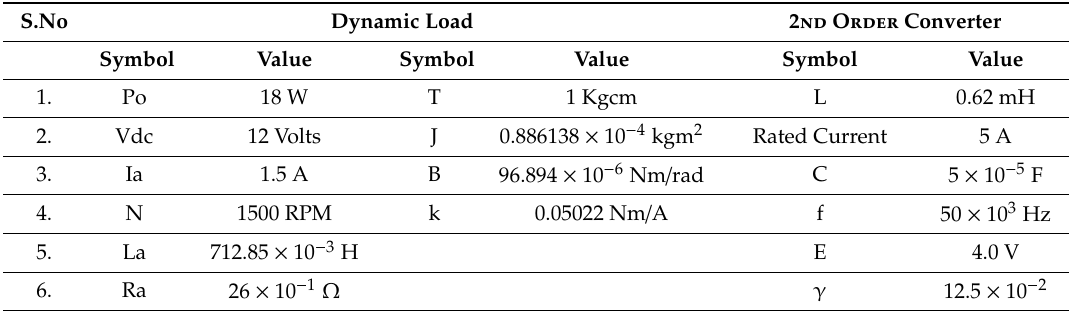
Table 3. Specifications of a partially flat boost power converter (2nd order) with a dynamic load. S.No